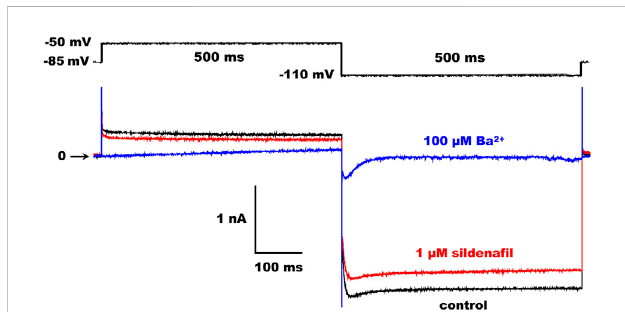
FIGURE 1 Scheme of the experimental protocol (upper panel) and representative Kir2.1 traces in control and under the effect of 1 µM sildena fi l or 100 µM Ba 2+ (lower